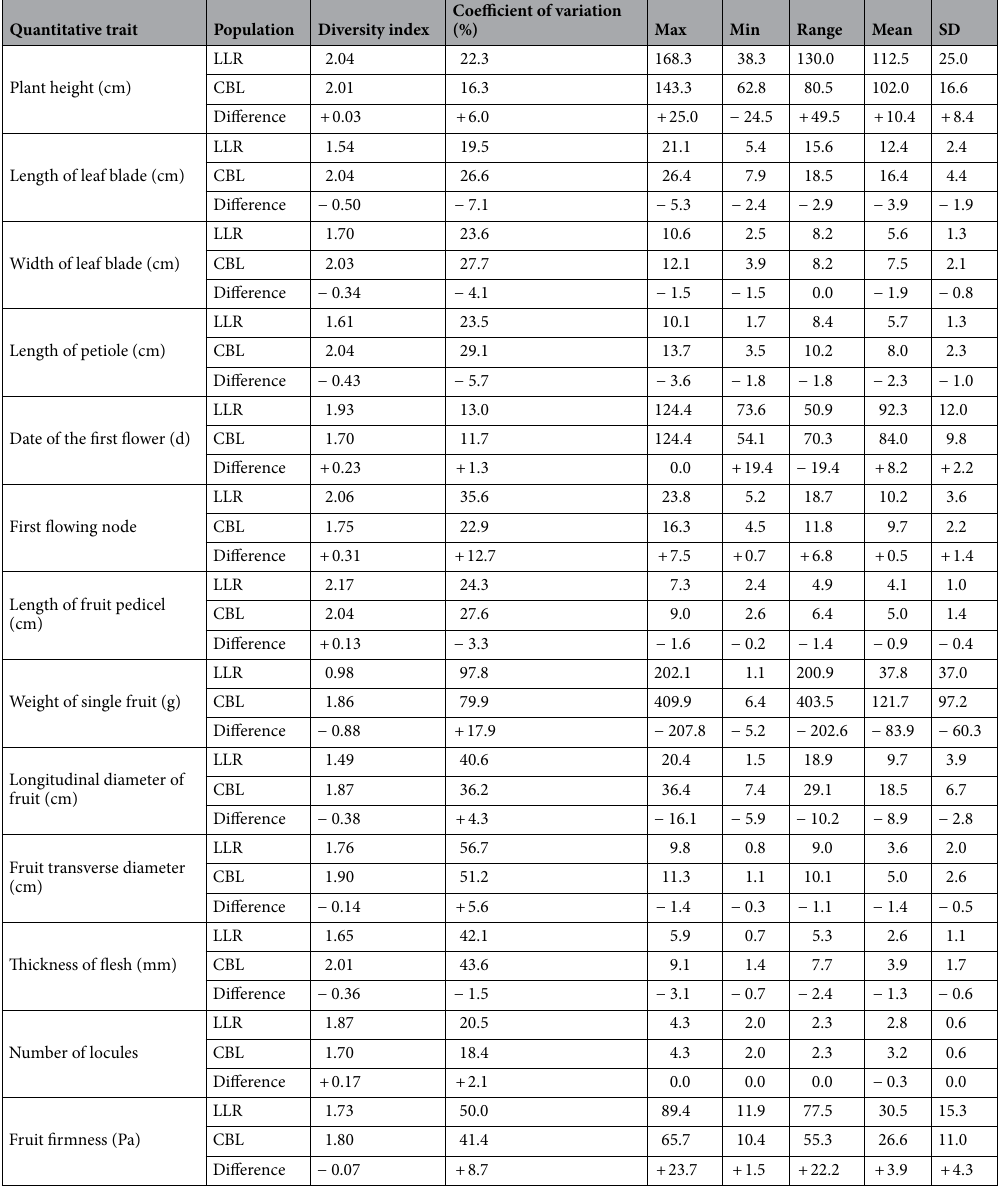
Table 3. Shannon Diversity indexes, coefficients of variation, and maximum, minimum, range, mean and standard deviation values and their differences for 13 quantitative traits evaluated in 94 local landrace (LLR) and 85 current breeding lines (CBL) of pepper in